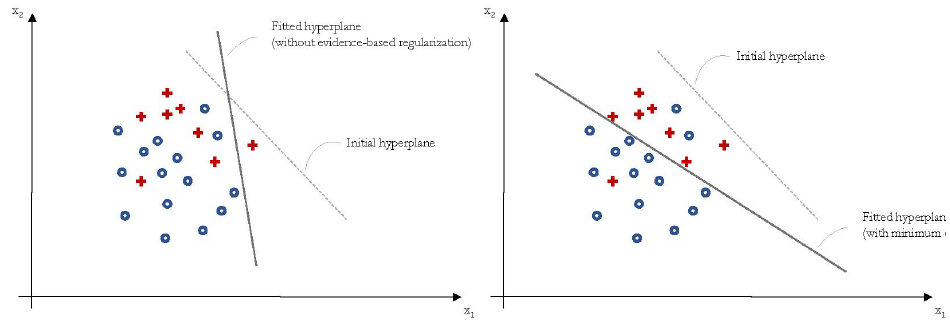
Figure 1. An example of a trained hyperplane potentially over-fitting the data ( left ) versus a hyper- plane supported by more evidence ( right